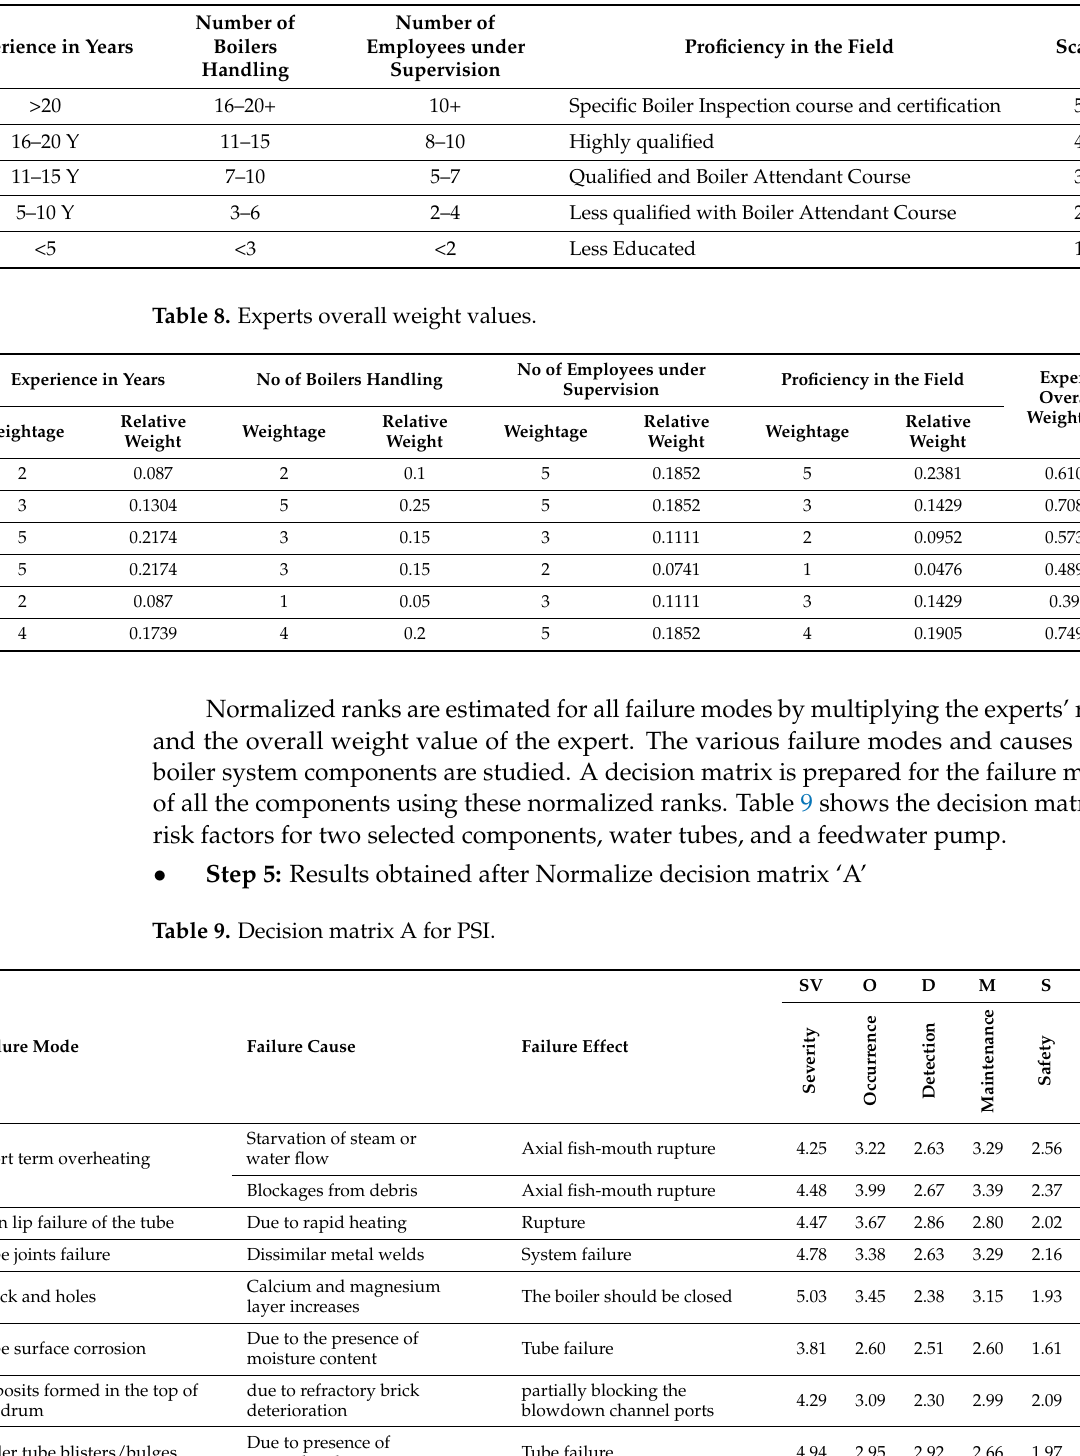
Table 7. Scale to assign experts weightage.